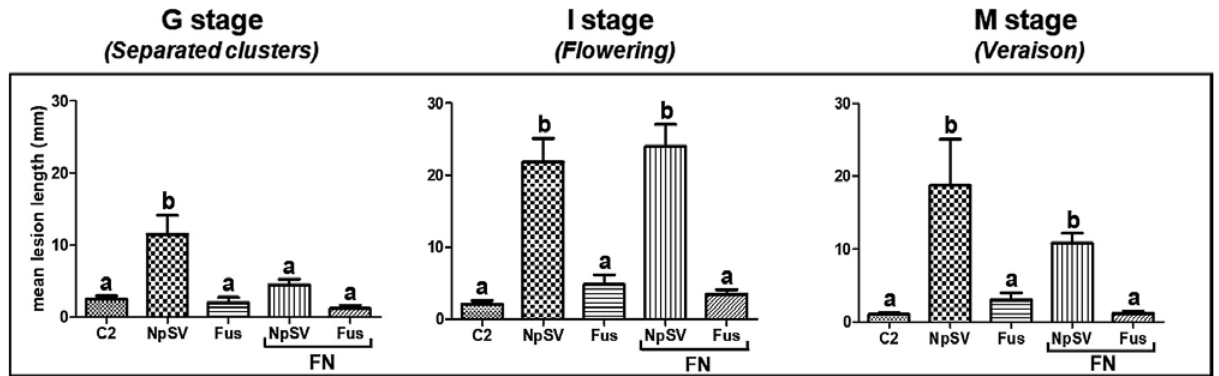
Figure 6. Mean lesion lengths (± SEs) on green grapevine stems after inoculation with N. parvum strain Saint Victoire and F. proliferatum strain Fus at the onset of the G, I and M stages, after single (NpSV, Fus) or dual ( Inoculation. Control stems (C2) were wounded and inoculated with sterile malt agar. Differences among the means were evaluated by the Dunn’s Multiple Comparison Test, following which the null hypothesis (equal means) was rejected in the Kruskal–Wallis test, assuming significance of P ≤ 0.05. Columns accompanied by the same letters are not significantly different ( P ≤